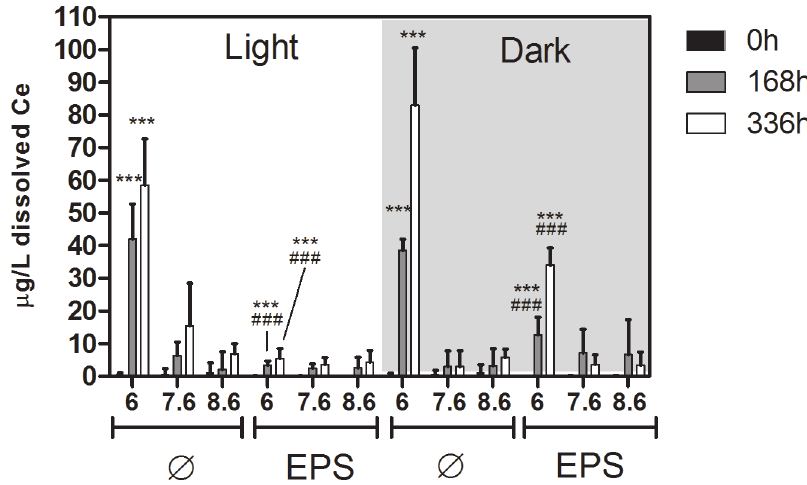
Figure 3. Mean mass concentrations with standard deviations of dissolved Ce in 5 mg/L CeO 2 NP dispersions directly after addition of NP (,,0 h’’) and after 168 h and 336 h of incubation as determined by ICP-MS of acid-digested samples. Samples were incubated in the dark or in light (100 m E/m 2 s). n=9 in 3 independent experiments, each experiment was done with one EPS extract. *** Significant difference between EPS-free and EPS containing samples; ### significant difference between light and dark treated samples, 168 h: p , 0.0001, df=11 (between groups), F=52.55, 336 h: p , 0.0001, df=11 (between groups), F=25.65.